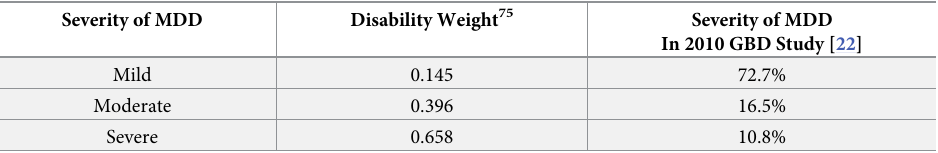
Table 6. Estimating the severity of co-morbid MDD in cutaneous